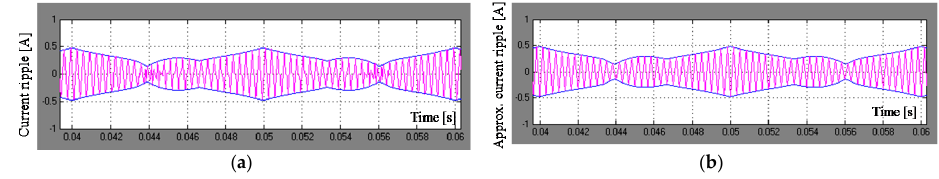
Figure 20. Approximation to evaluate current ripple rms in the example case of DPWM+, m = 1/3: ( a ) instantaneous ripple (simulated, pink trace) with calculated envelope (blue trace); and ( b ) pure triangular waveform modulated by the same calculated envelope.